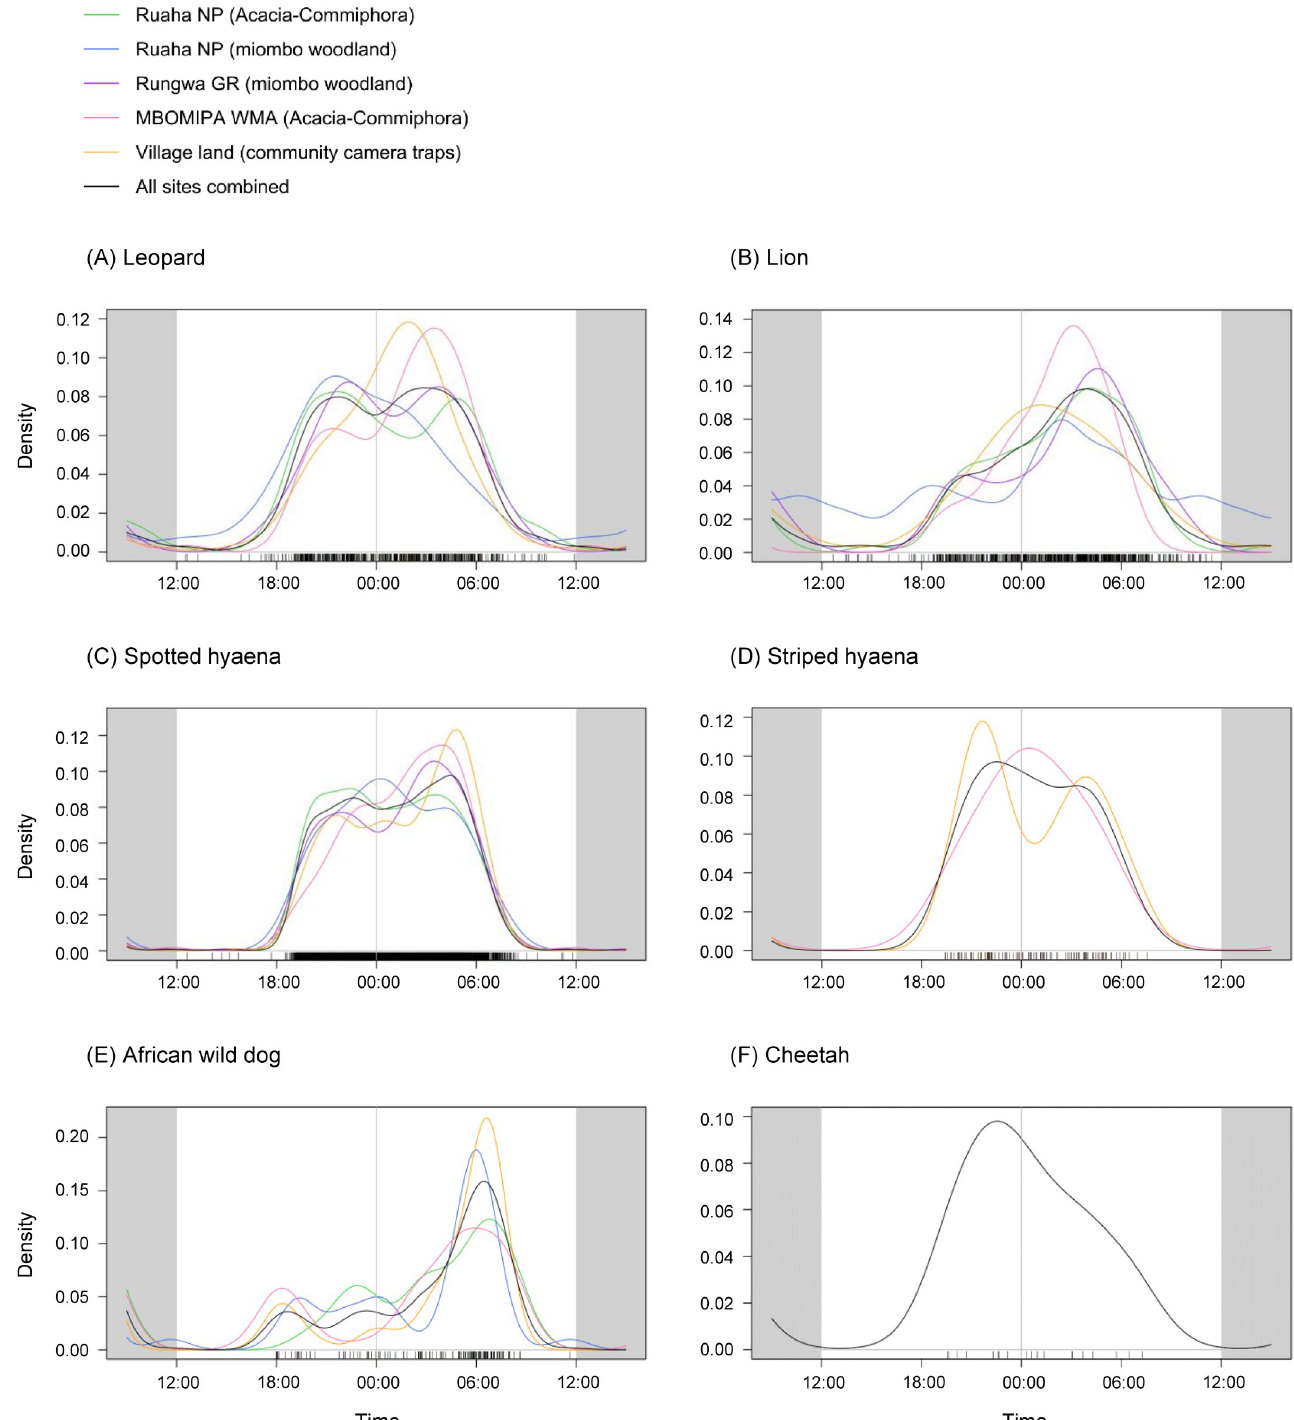
Fig 2. Kernel density function plots of large carnivore activity in Ruaha-Rungwa, centred on midnight (00:00). Plotted using package overlap [44]. Kernel density functions were fitted to all unique capture events of (A) leopard, (B) lion, (C) spotted hyaena, (D) striped hyaena, (E) African wild dog, and (F) cheetah, using camera trap data from four systematic camera trap grids, and from cameras deployed non-systematically in village land. Striped hyaena were only recorded in MBOMIPA WMA and village land (community camera traps), while insufficient captures of wild dog were obtained in Rungwa GR (n = 5) for activity to be modelled in this site. Due to a low number of overall captures (n = 22), cheetah activity is only plotted for all sites combined.